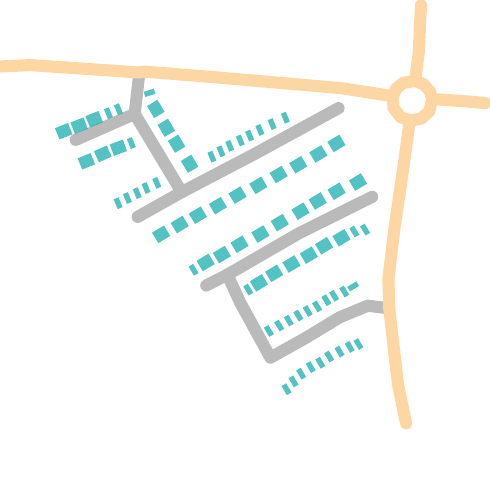
Figure 7. A set of polygons corresponding to houses in a housing estate and a number of lines corresponding to roads are represented. The grey lines represent the access roads for the housing estate in question. Data taken from